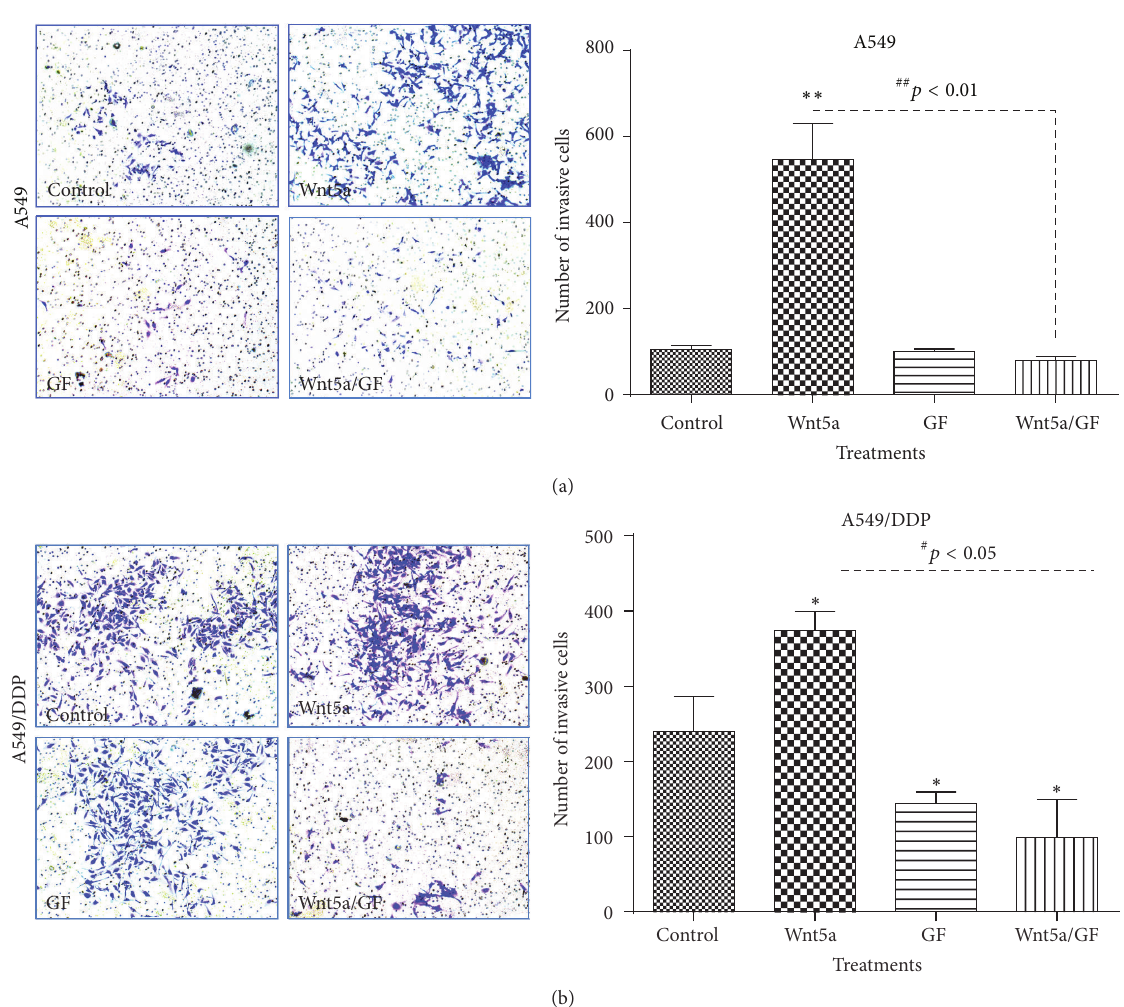
Figure 3: Wnt5a promotes cell invasion in lung cancer cells in vitro . A549 and A549/DDP cells were cultured with Wnt5a-CM with or without PKC inhibitor GF109203X in matrigel-coated transwells. The capability of cell invasion was accessed by a transwell assay. (a) Representative images of transwell assays for A549 cells (left panel) and its relevant quantification of the numbers of invasive cells (right panel). (b) Representative images of scratch assays for A549/DDP cells (left panel) and its relevant quantification of the numbers of invasive cells (right panel). Wnt5a showed an ability to significantly enhance cell invasion in both A549 and A549/DDP cells. In contrast, GF109203X was able to inhibit the Wnt5a-promoted invasion in these cells. Compared with Control-CM group, ∗ represents 𝑝 < 0.05 ; ∗∗ : 𝑝 < 0.01 . Data represented the mean ± SD from three independent triplicated experiments ( 𝑁 = 9 ). GF: